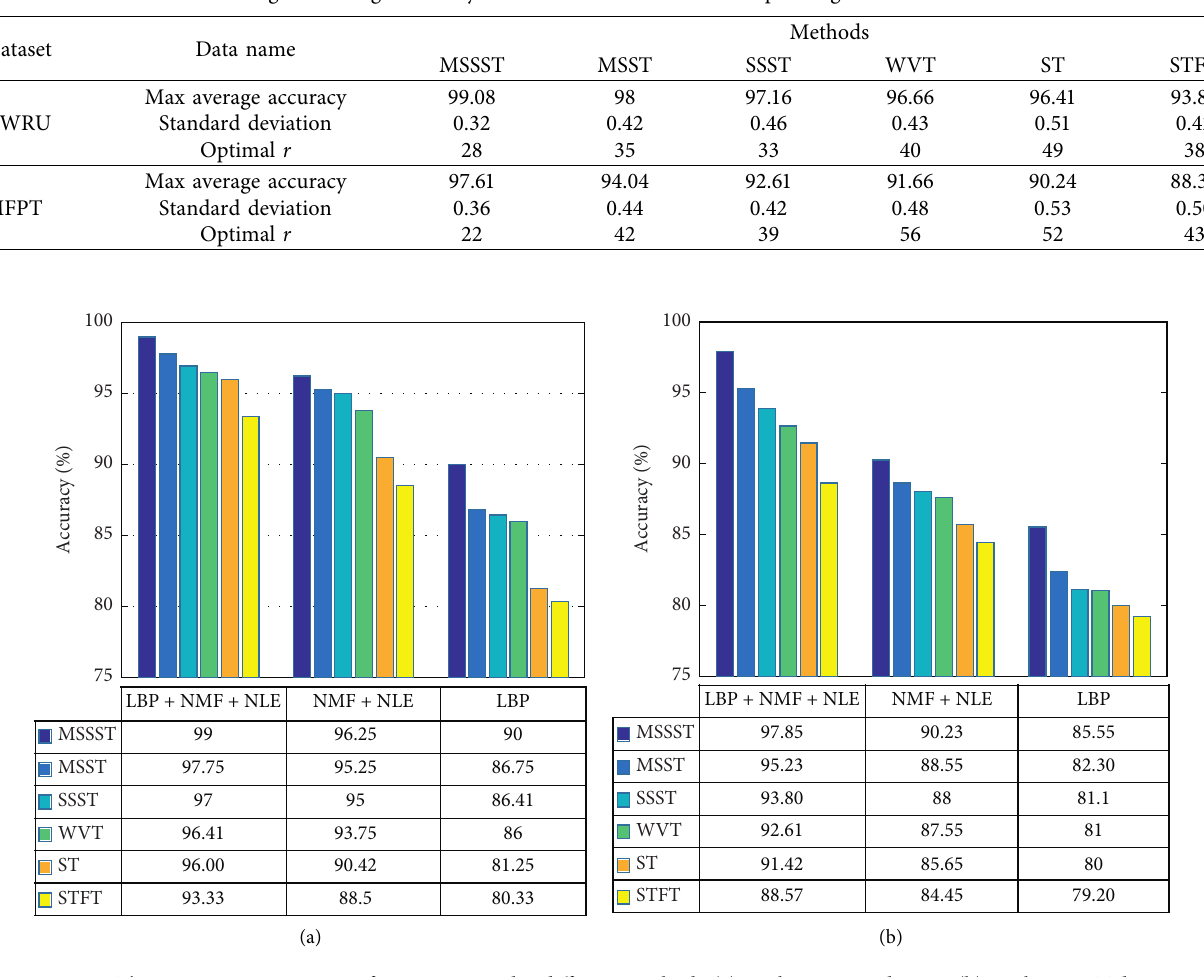
Table 4: The highest average accuracy of validation set and its corresponding standard deviation and r .